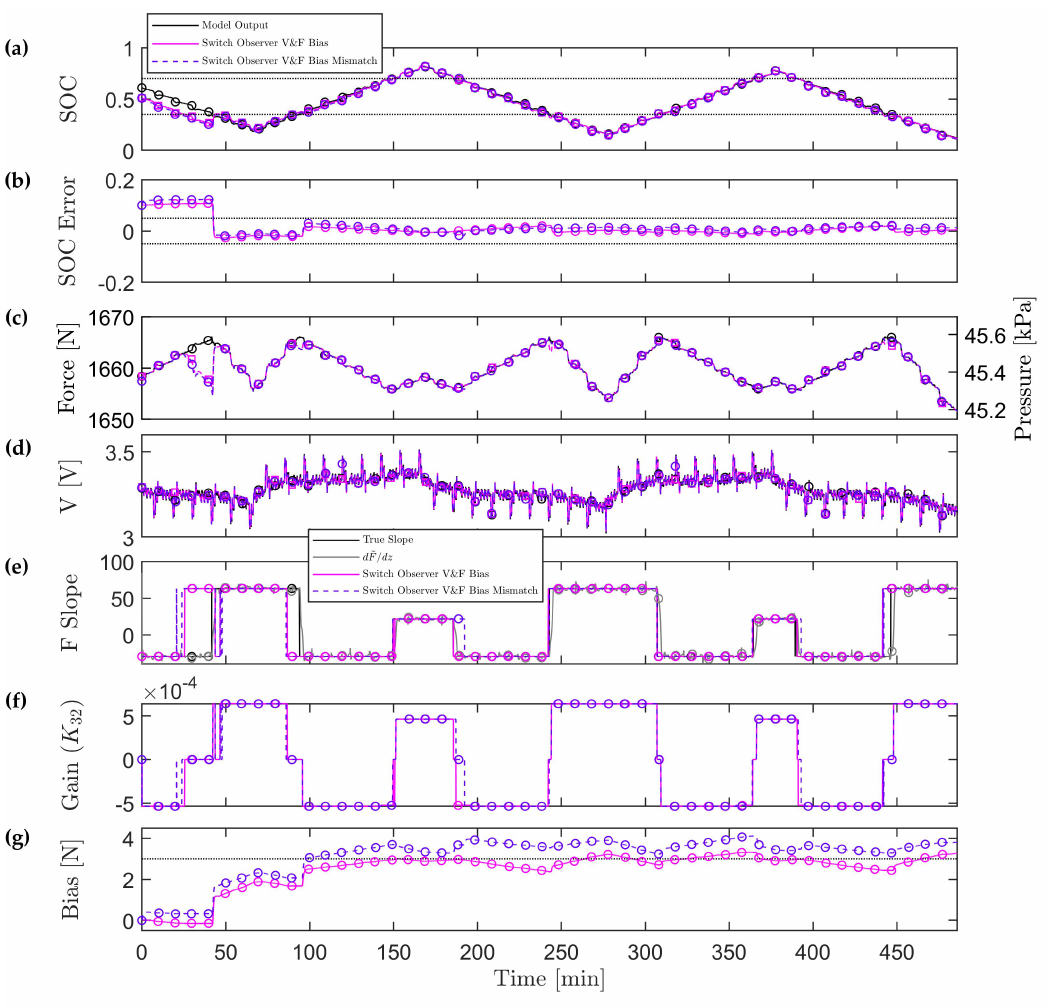
Figure 7. Simulation of the impact of model mismatch in the inflection points of the force vs. SOC curve. A 10% error in ˆ b L and ˆ b H is tested for the observer (Switch Observer V&F Bias) with an emulated bias of 3 N and 10% (0.1) initial SOC error. ( a ) Comparison of the simulated state of charge (SOC). ( b ) Comparison of the state of charge (SOC) error with the dashed lines representing the target ± 5% bound. The SOC error converges to within the ± 5% error bound. The largest SOC errors are observed near the switching points denoted by the horizontal dashed lines in Figure 7a. ( c ) Comparison of the simulated force and observer output. For generalization of the results to the other cell sizes, the pressure is shown. ( d ) Comparison of the simulated terminal voltage and observer output. ( e ) Comparison of the true slope with the estimated slope d ˜ F and observer output. ( f ) Comparison of the feedback gain dz K 32 from force to SOC based on the switching logic. The gain is set to zero when there is mismatch in the estimated slope and that based on the observer SOC. ( g ) The Bias state estimate converges slowly. The impact of model mismatch in the inflection points of the force vs. SOC curve can be seen by comparing the (Switch Observer V&F Bias Mismatch) and (Switch Observer V&F Bias) which uses the correct value. The accurate observer converges to the true value of 3 N, denoted by the dashed horizontal line whereas mismatch leads to a constant over-estimate of about 1